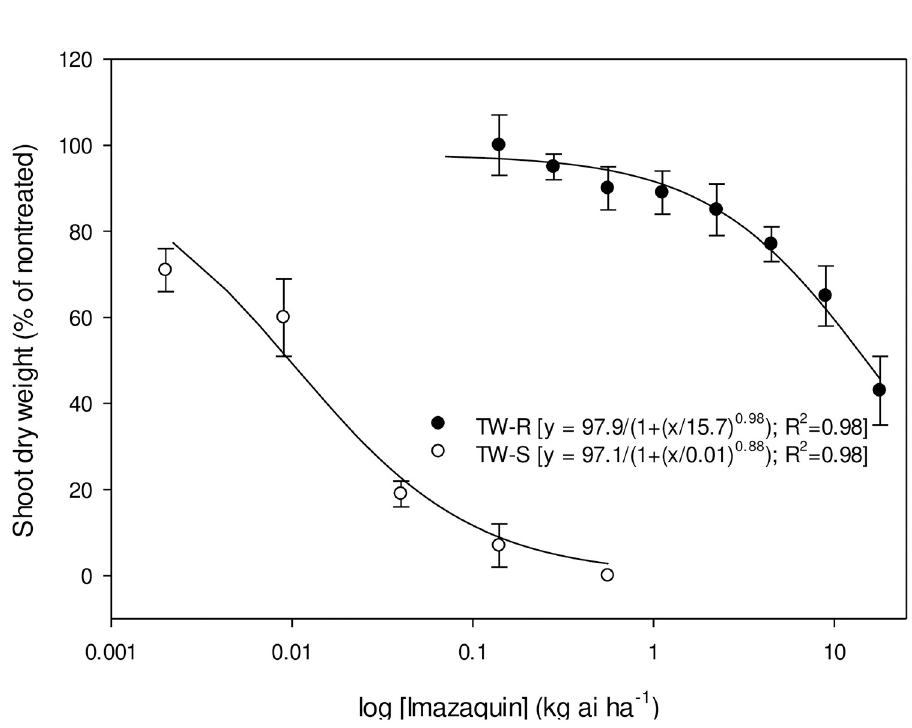
Fig 5. Imazaquin dose response on shoot dry weight reduction of ALS-inhibiting herbicide-resistant (TW-R) and -susceptible (TW-S) Amaranthus tuberculatus populations from Mississippi 3 wk after treatment. Vertical bars represent standard error of